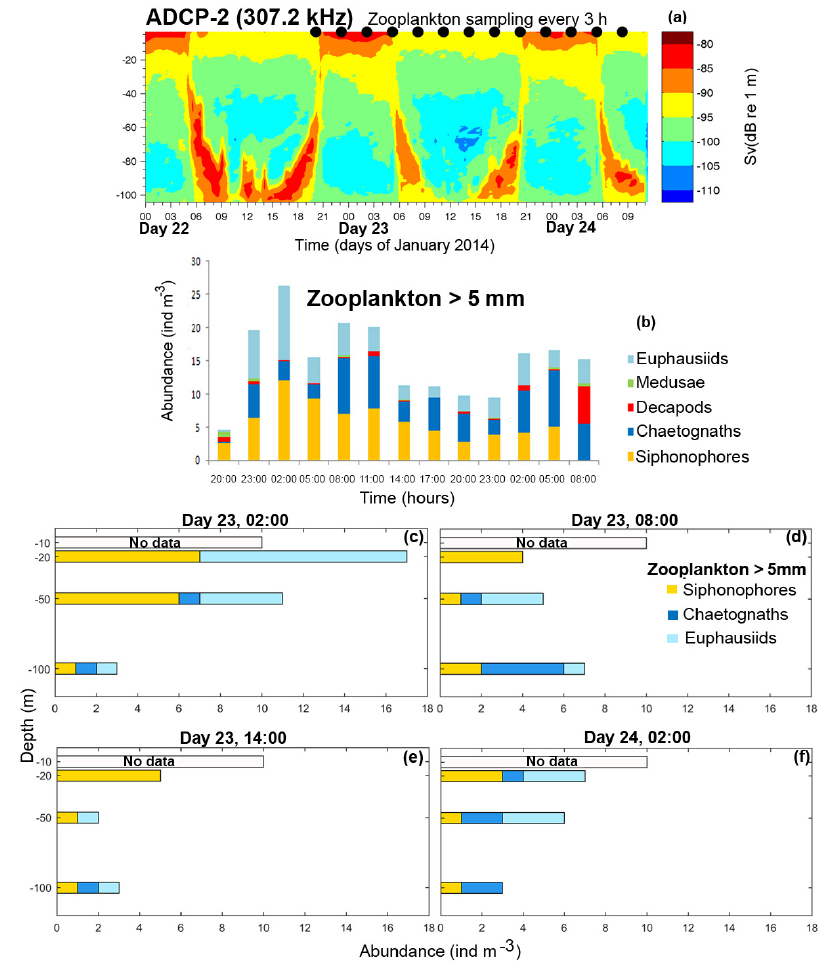
Figure 4. (a) Volume backscattering strength ( S v ) calculated from the ADCP-2 backscatter signal in Puyuhuapi Fjord from 22 to 24 Jan- uary 2014. The in situ zooplankton sampling (in 03:00 intervals) are represented by black dots at the surface. (b) Depth-integrated abundance of zooplankton from the surface to 100m depth varying throughout time, where (b) is zooplankton > 5mm in length. (c) Vertical abundance of the principal zooplankton groups on 23 January at 02:00 (nighttime) and (d, e, f) same as (c) but on 23 January at 08:00 and 14:00 (daytime) and 24 January at 02:00 (nighttime). The time reference is in local